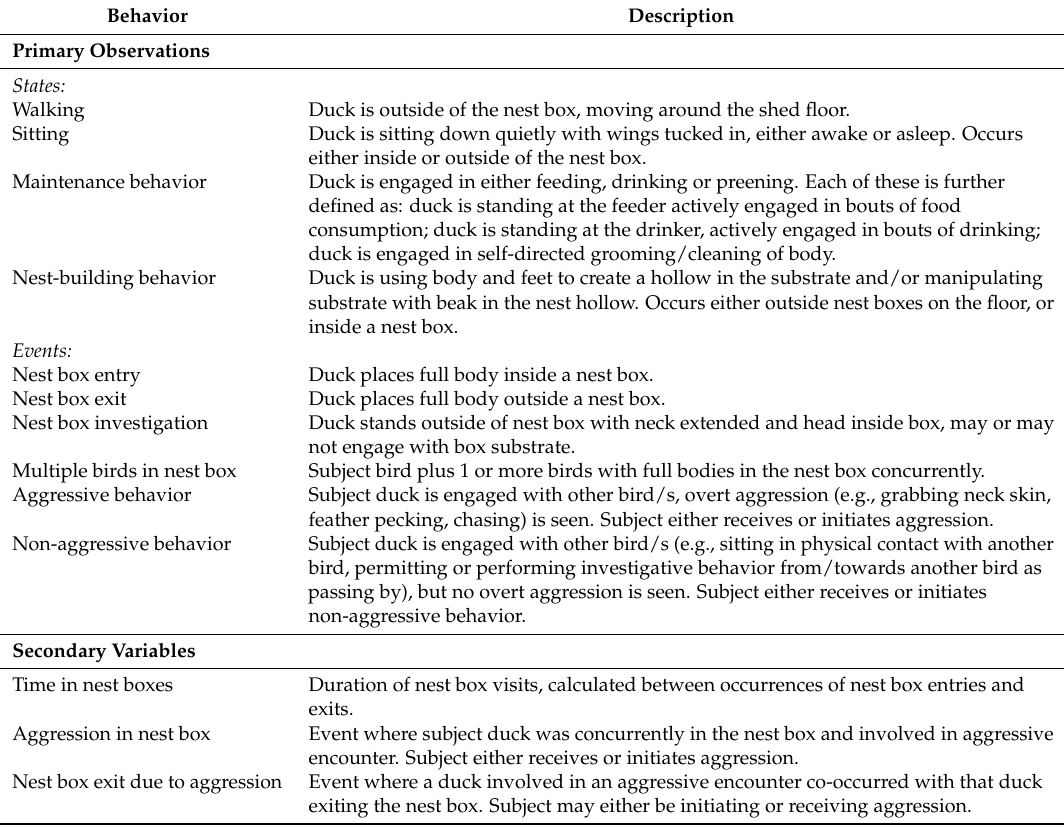
Table 1. Ethogram used for statistical analysis. Primary observations are those behaviors that were directly observed from the video footage of the hour prior to oviposition site selection. Secondary variables were created using either the contingency analysis or co-occurrence function of Interact